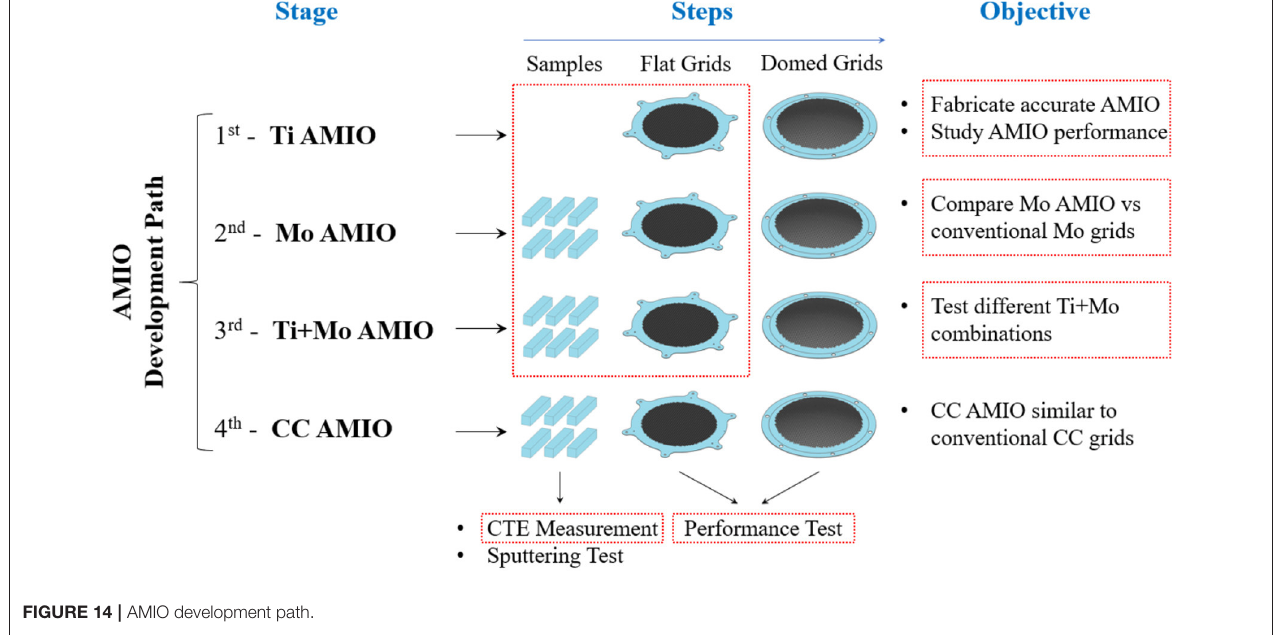
FIGURE 14 | AMIO development path.